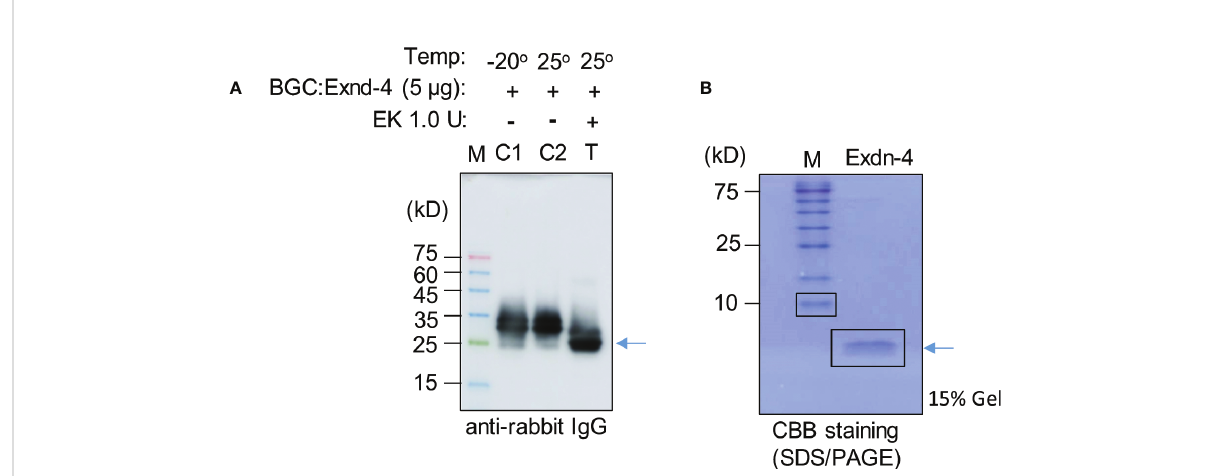
FIGURE 5 Exdn-4 is produced without any extra domains by cleavage of BGC : Exdn-4 with enterokinase. (A) Enterokinase cleavage of BGC : Exdn-4. Puri fi ed BGC : Exdn-4 bound onto MCC beads (50 µL/5 µg proteins) beads was treated with (T) or without (C2) 1.0 U of Enterokinase at 25°C for 12 h. After incubation, proteins bound to MCC beads were released in the SDS/PAGE sample buffer by boiling and analyzed by Western blotting using HRP- conjugated anti-rabbit IgG antibody. As a control, untreated protein (C1) was loaded. Arrow, BGC without Exdn-4. (B) Analysis of Exdn-4 released from BGC : Exdn-4. Exdn-4 released in the supernatant during the enterokinase treatment was collected and analyzed in by 15% SDS/PAGE gel followed by CBB staining. Arrow,